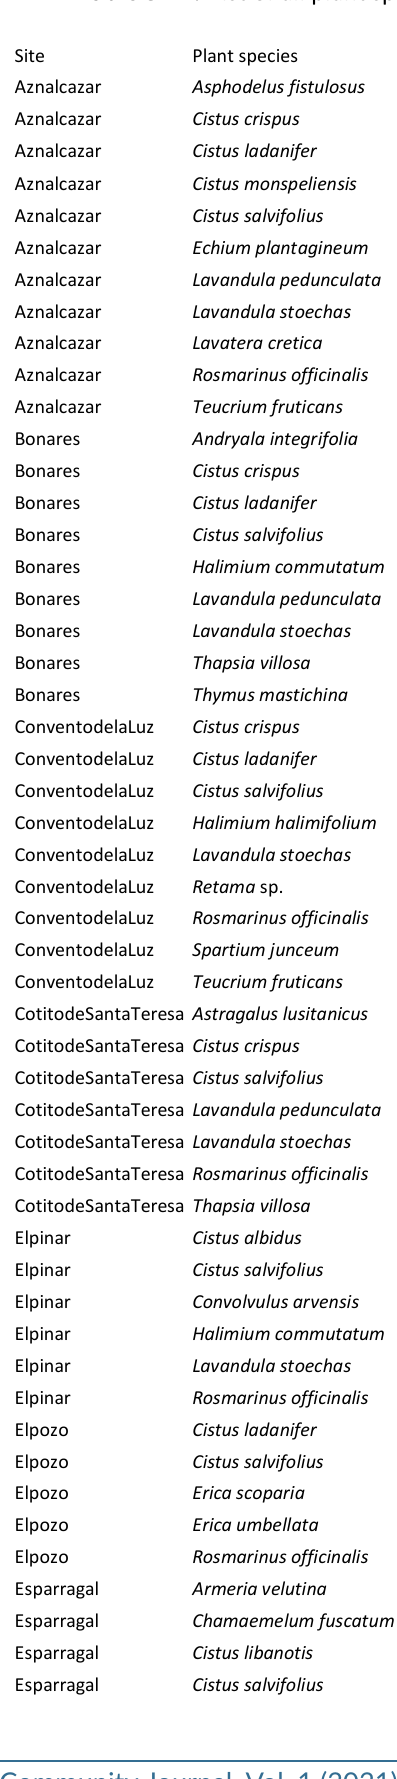
Table S1A. List of all plant species present at each of the sites and included in network